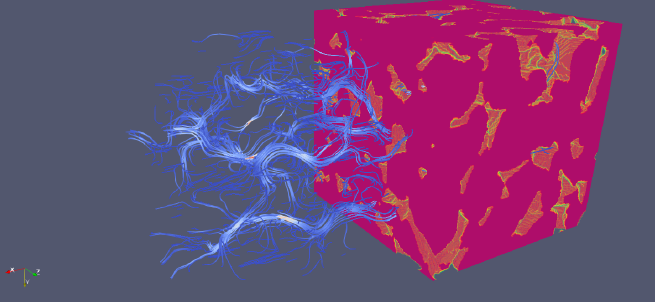
Figure 6. The flow field of porous medium flow simulation using Taichi-LBM3D: left: streamline of velocity field, right: initial geometry of porous structure. The domain is 131 3 lattice units,and the fluid viscosity is 0.1 in a lattice